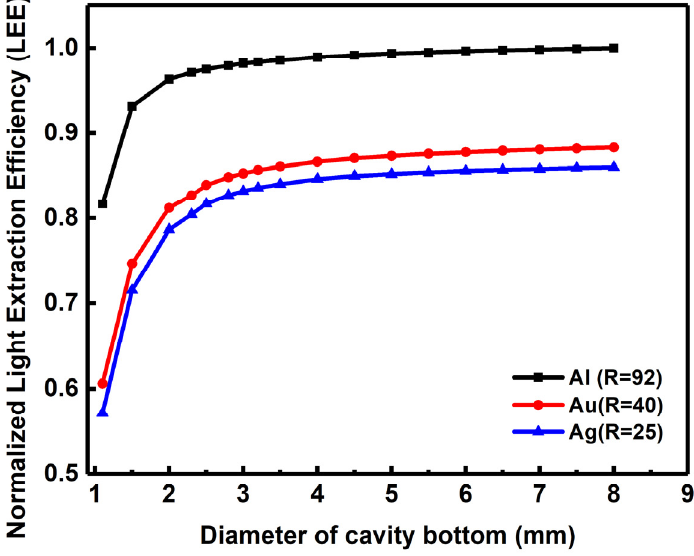
Figure 5. Simulated light-extraction efficiencies (LEEs) of DUV-LEDs with cavity-bottom diameters of 1.1–8 mm.